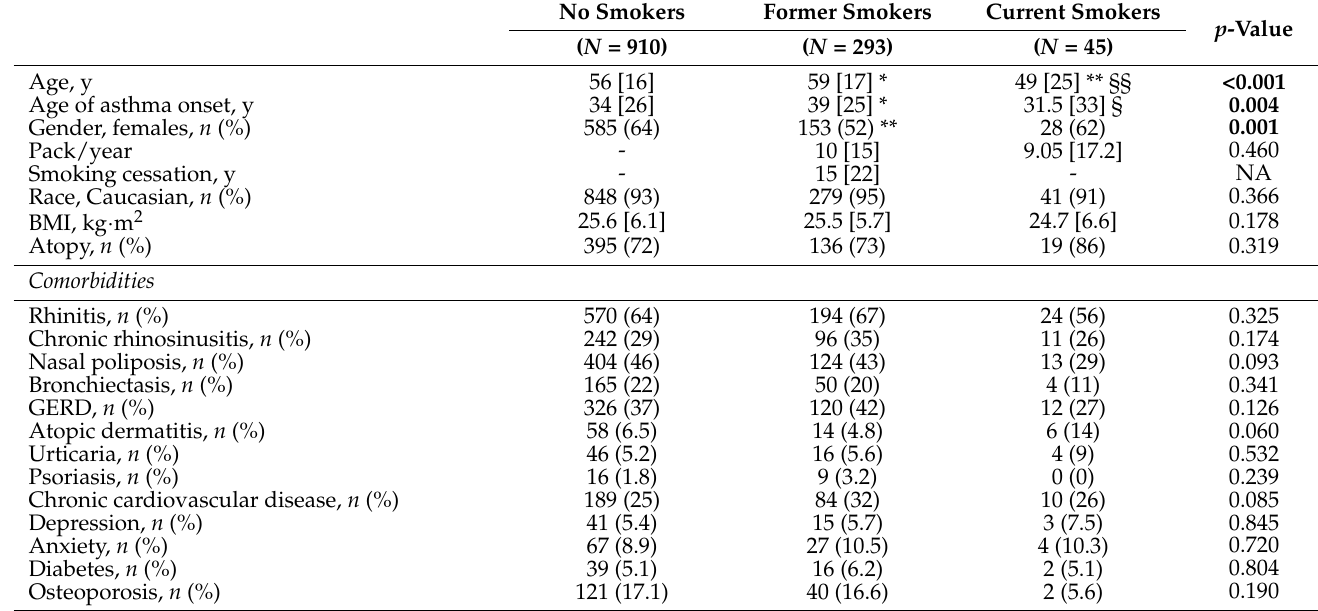
Table 1. Demographic data and comorbidities of severe asthma study